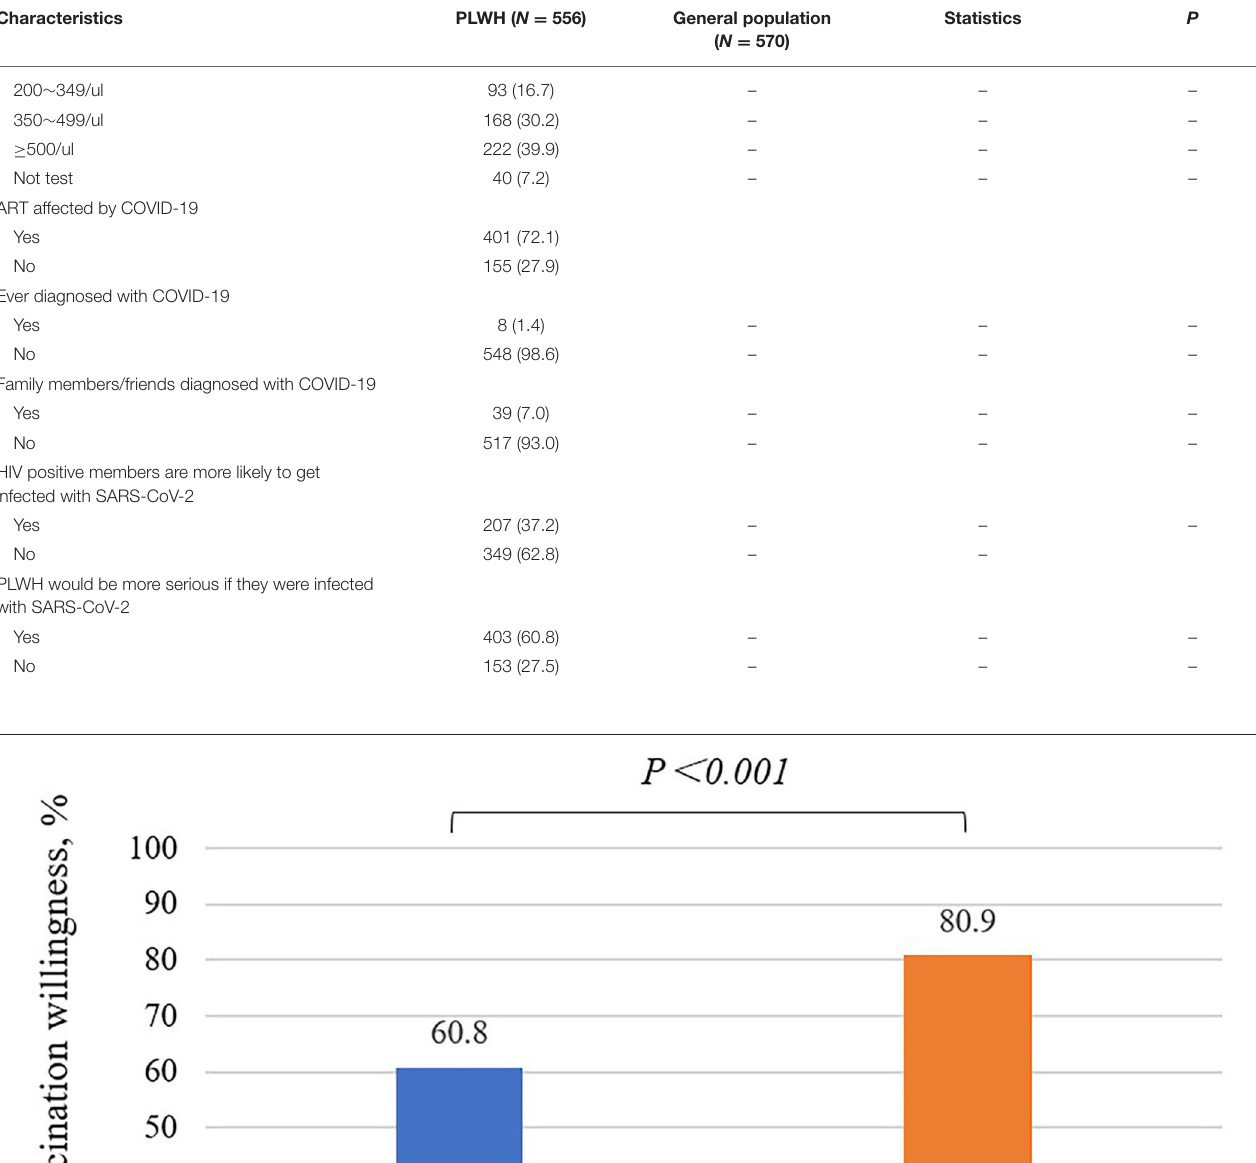
Frontiers in Public Health |